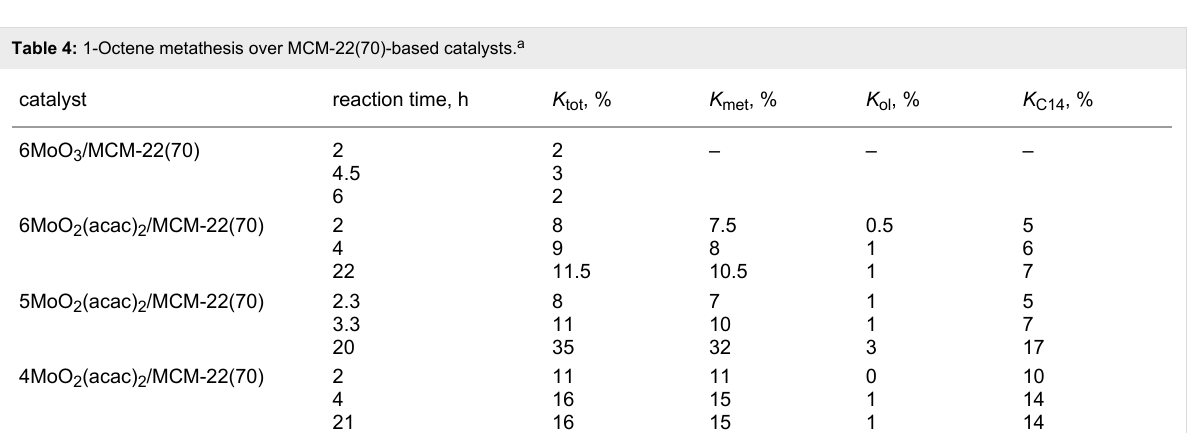
Table 4: 1-Octene metathesis over MCM-22(70)-based catalysts. a